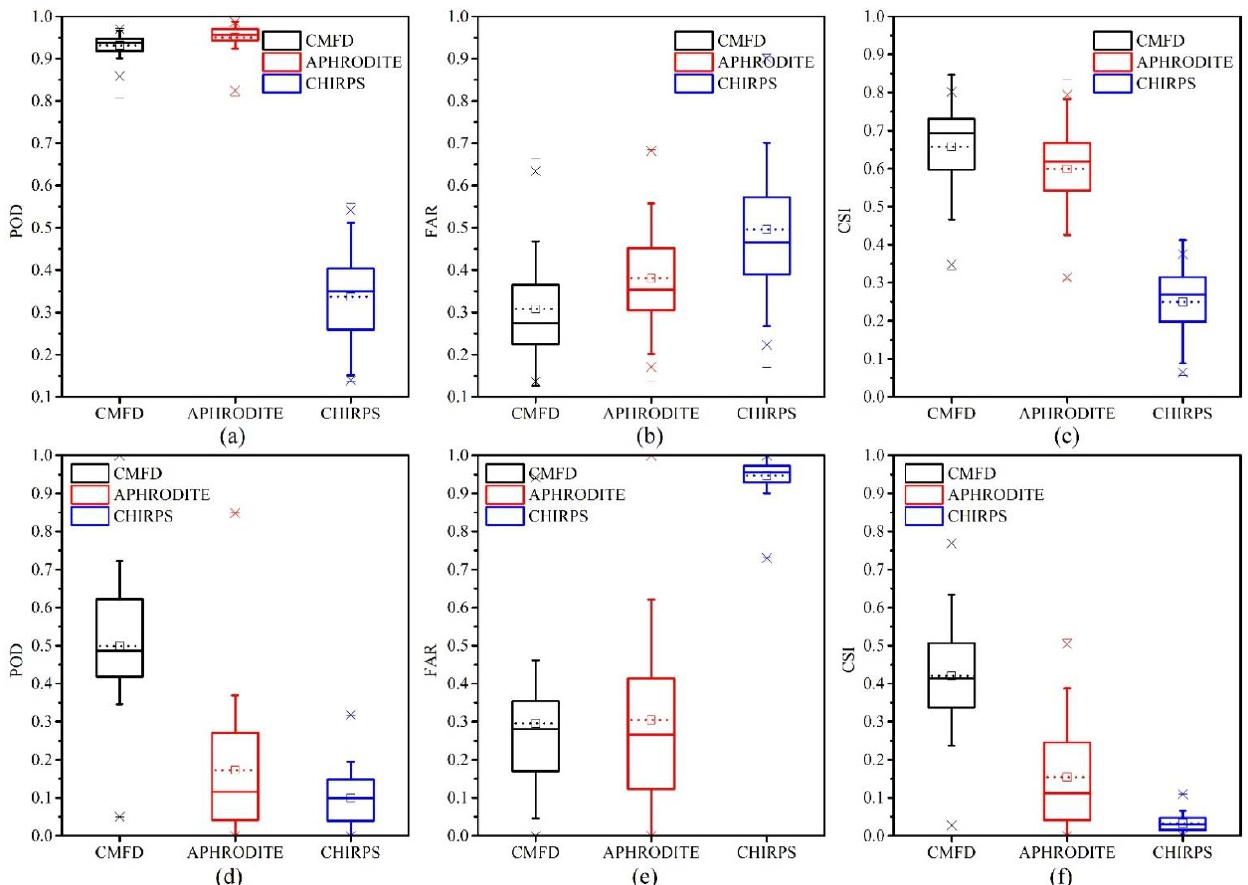
Figure 21. Boxplots of the POD, FAR, and CSI for general rain events ( a – c ) and heavy and extreme rain events ( d – f ) as derived from CMFD, APHRODITE, and CHIRPS at 101 rain gauges, respectively.